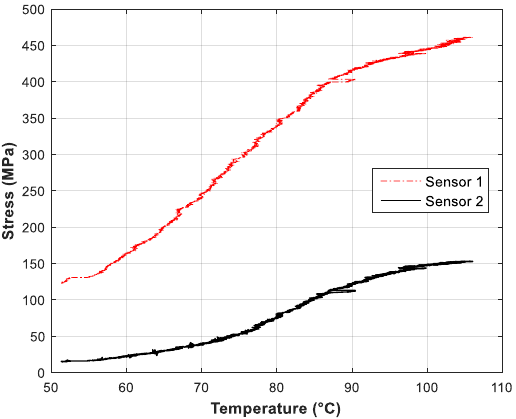
Figure 19. The von-Mises stress measured by the strain gauge sensors installed in the iron surfaces. Sensor 1: Tooth side, Sensor 2: Yoke side.